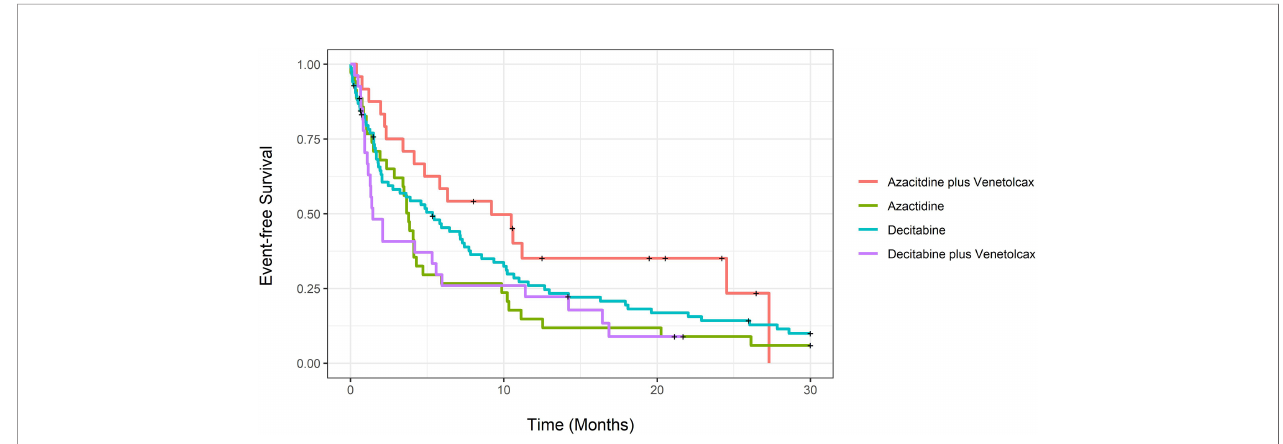
FIGURE 2 | Unadjusted event-free survival for newly diagnosed acute myeloid leukemia patients treated with azacitidine with venetoclax, azacitidine, decitabine with venetoclax or